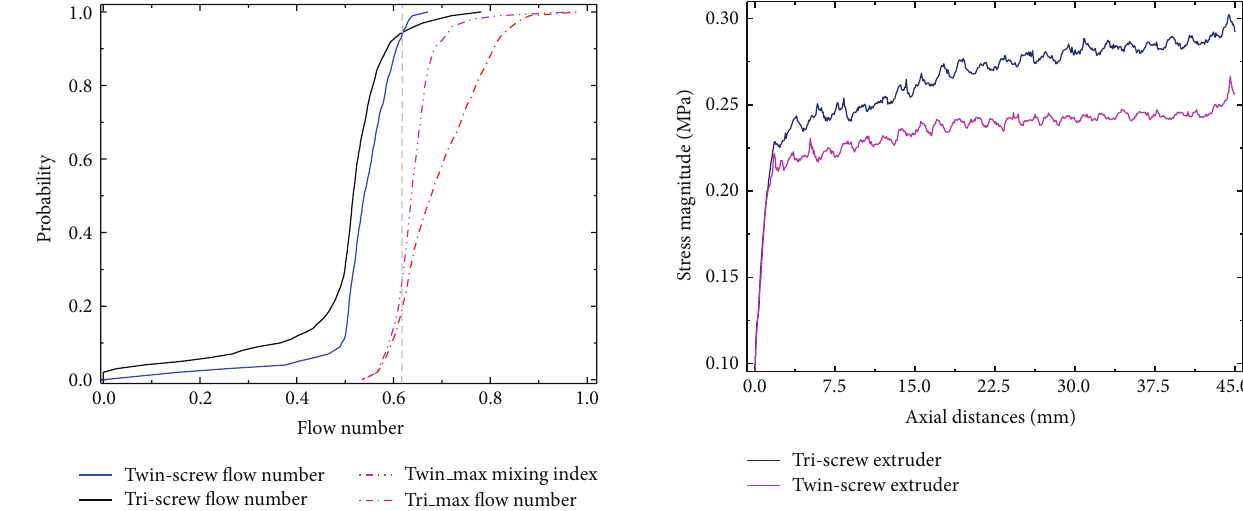
Figure 8: Stress magnitude distributions in two kinds of